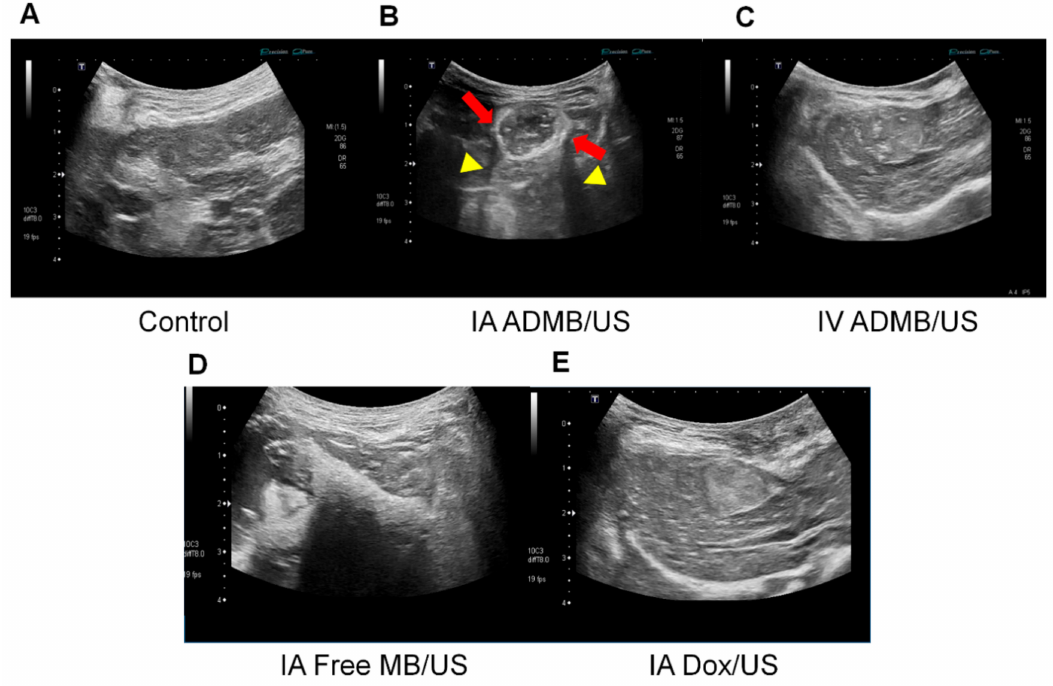
Figure 6. Representative ultrasound images of ( A ) control, ( B ) intraarterial injection of ADMB (IAMB / US), ( C ) intravenous injection of ADMB (IVMB / US), ( D ) intraarterial injection of microbubble (IA Free MB / US) and ( E ) intraarterial doxorubicin (IA Dox / US). Note that strong rim-like enhancement of intratumoral vessels (arrow) with posterior shadow (arrowhead) in IAMB / US